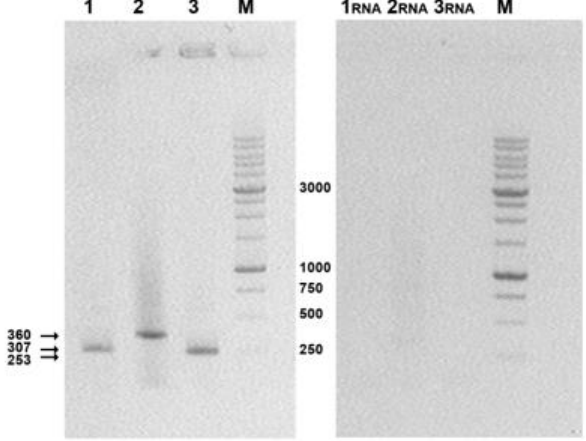
Figure 4. Electrophoretic analysis of RT-PCR products in 1% agarose gel. 1, 2, 3, RT-PCR products were obtained using cDNAs from 293T cells transfected with the target plasmids: 1, p-AgH1; 2, p-AgH3; 3, p-AgM2; 1 RNA , 2 RNA , and 3 RNA , PCR reaction in these probes was performed without reverse transcription of RNAs isolated from transfected 293T cells (this was done to check both primers specificity and the lack of plasmids admixtures); M, M12 oligonucleotide size markers produced by SibEnzyme (DNA fragments 10000, 8000, 6000, 5000, 4000, 3000, 2500, 2000, 1500, 1000, 750, 500, and 250 bp).